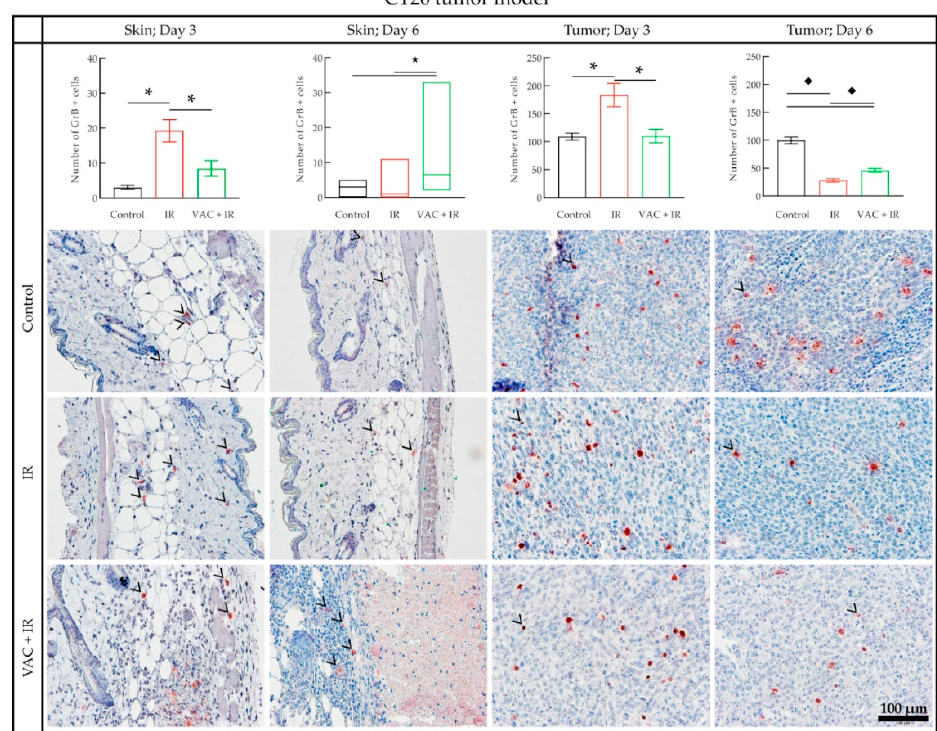
Figure 8. Histological analysis of the CT26 tumor model samples. The number of GrB+ cells in IHC ‐ stained skin samples. Data were plotted as the line at the median with the data range (min, max) (Tumor; Day 3) or as the mean ± standard error (SE) (Skin; Day 3, Skin; Day 6, Tumor; Day 6). Representative images of the samples stained for GrB+ cells for each therapeutic group are under the graphs. The black arrowhead indicates the red GrB+ cells. GrB+ = Granzyme B positive cells; * = P < 0.05 determined by Dunnet’s T3 multiple comparisons test; = p < 0.05 determined by Dunn’s multiple comparisons test; = p < 0.05 determined by Tukey’s multiple comparisons test; IHC = immunohistochemically; VAC = 1 unit of the CT26 vaccine (0.5 mg), prepared using the adjusted vaccine preparation protocol, including IL ‐ 12 GET; IR = tumor irradiation with 15 Gy; GET = gene electrotransfer.